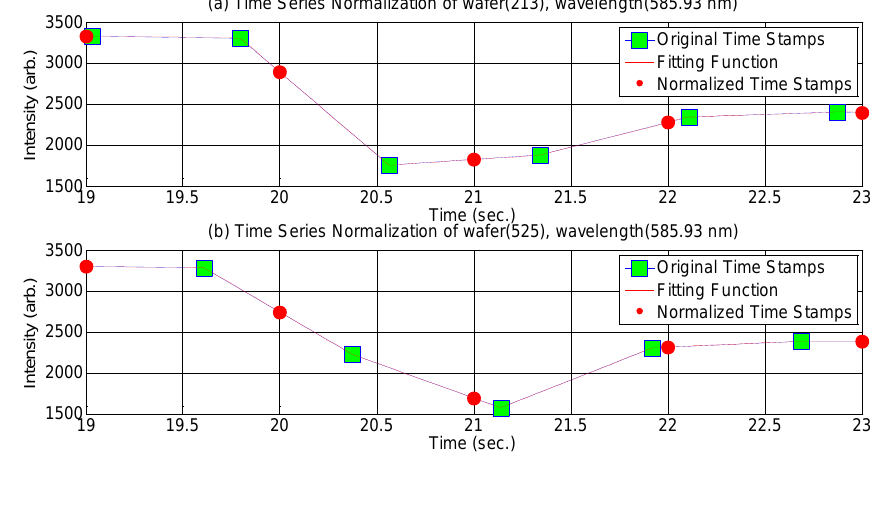
Figure A2. Original and normalized time series of wavelength (585.93 nm) from ( a ) sample 213 and ( b ) sample